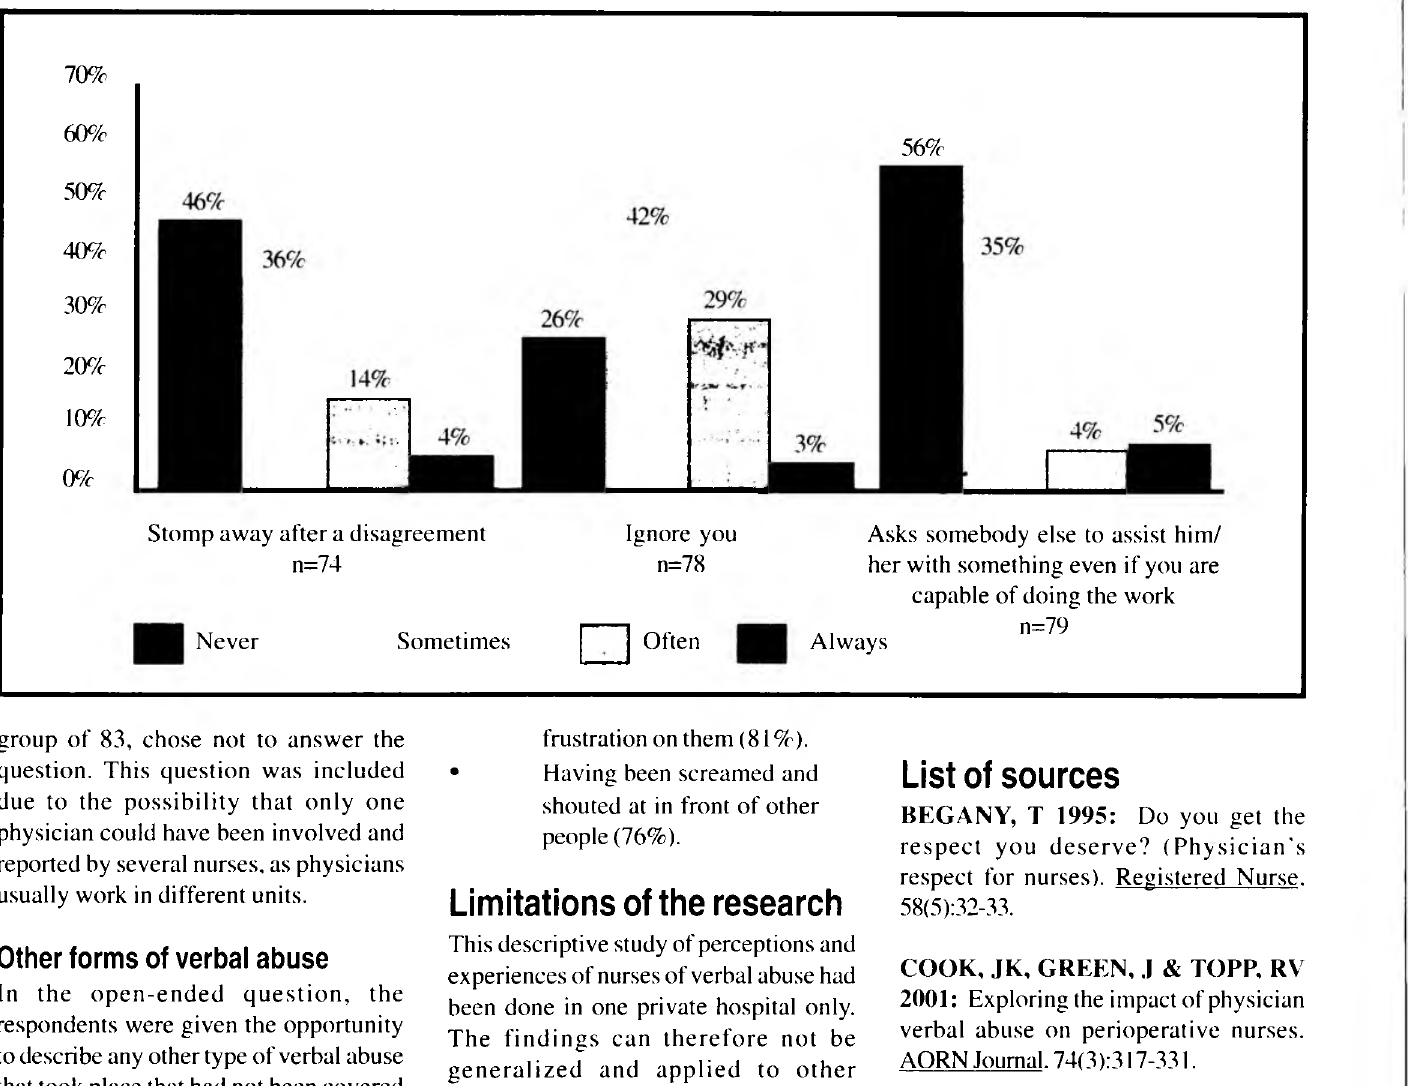
Figure 6: Forms of being overlooked experienced by